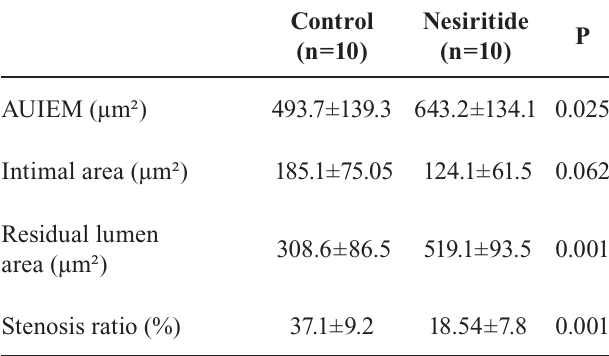
TABLE I - C omparison of remodeling indices between nesiritide and control group